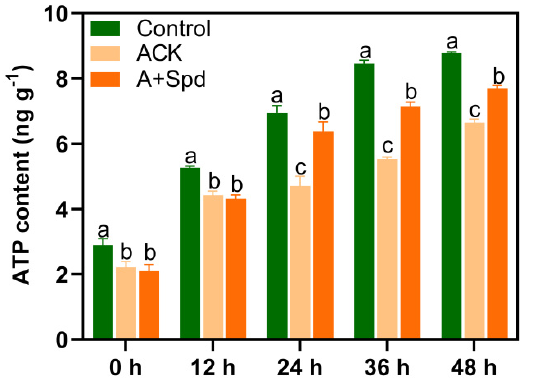
Figure 8. Effects of exogenous Spd on ATP content of aged seeds during germination. Control − healthy seeds; ACK − artificially aged seeds; A+Spd − aged seeds with Spd treatment. A total of five time points from 0 to 48 h after germination were performed for each treatment. Different lowercase letters above the bars indicate significant levels of difference among the three treatments ( p < 0.05, Lsd). A 0.05 μ M concentration of exogenous Spd was used.